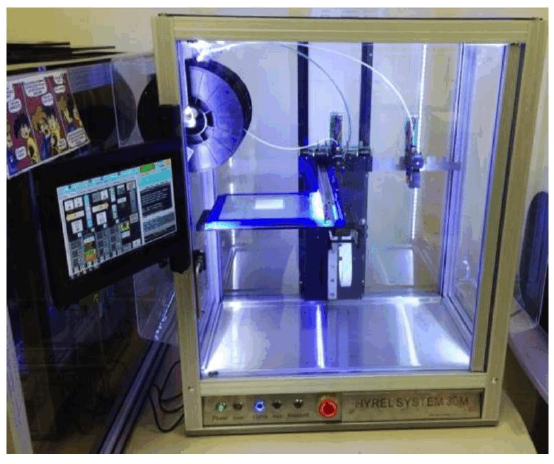
Figure 9. Hyrel System 30 3D printer [60].